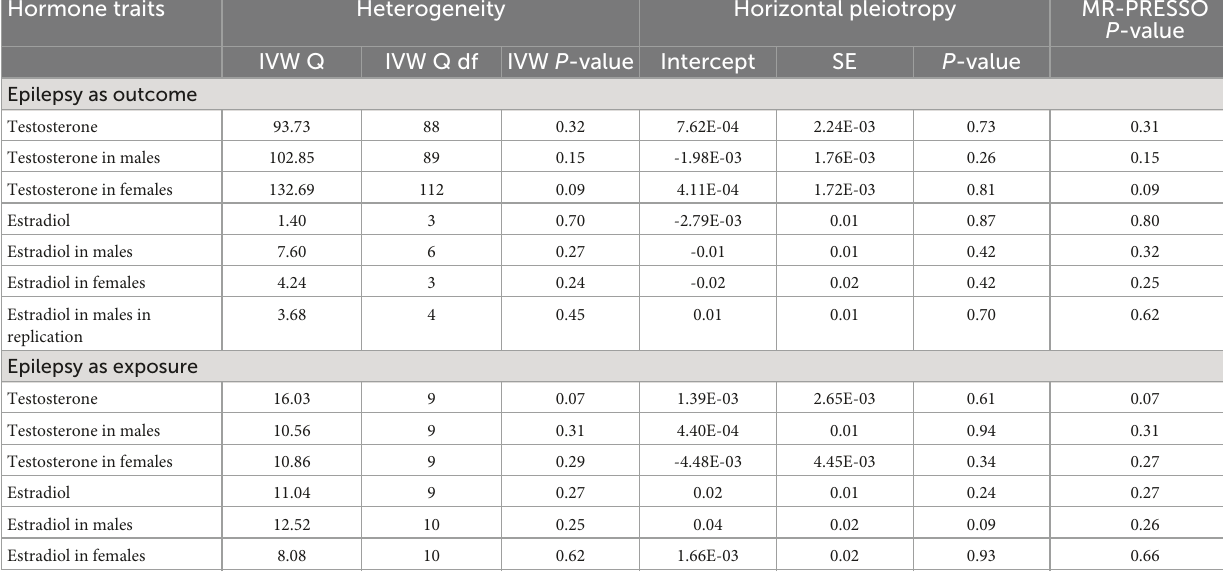
TABLE 1 Heterogeneity and horizontal pleiotropy analyses between hormone traits and epilepsy. Hormone